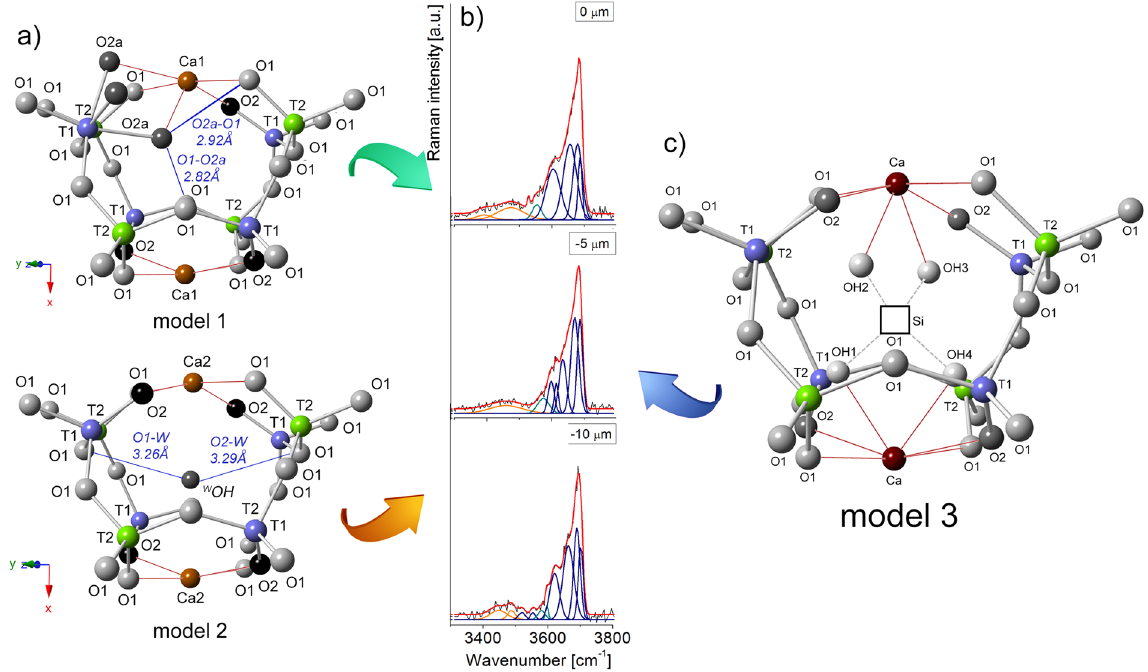
Figure 6. ( a ) Theoretical models of chlormayenite cages based on the diffraction data, ( b ) Raman spectra in hydroxyl stretching region measured in depth profile, ( c ) hydroxyl group arrangement into the structure of chlormayenite. The images were projected onto (0–23) in which O 1 , O 2 or O 2a atoms are highlighted as potential acceptors for hydrogen